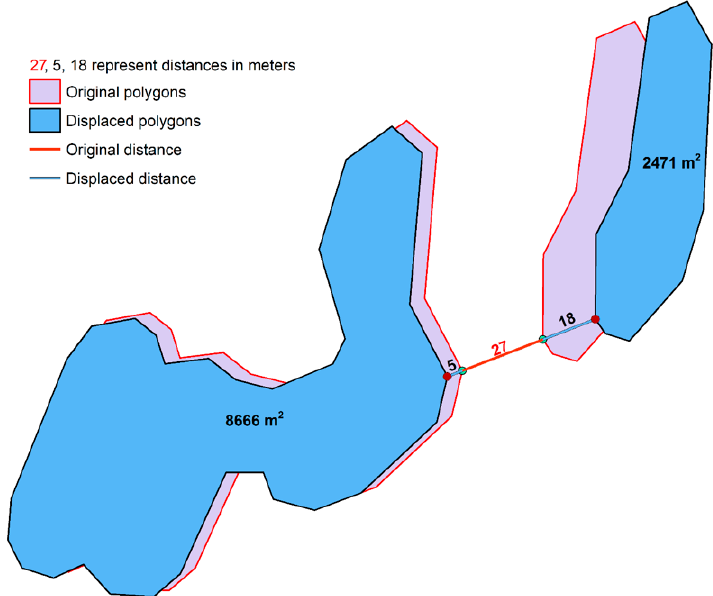
Figure 7. Pairwise displacement: Finding the closest points and calculating the displacement vector based on the proportion the polygons contribute to propagating the displacement.